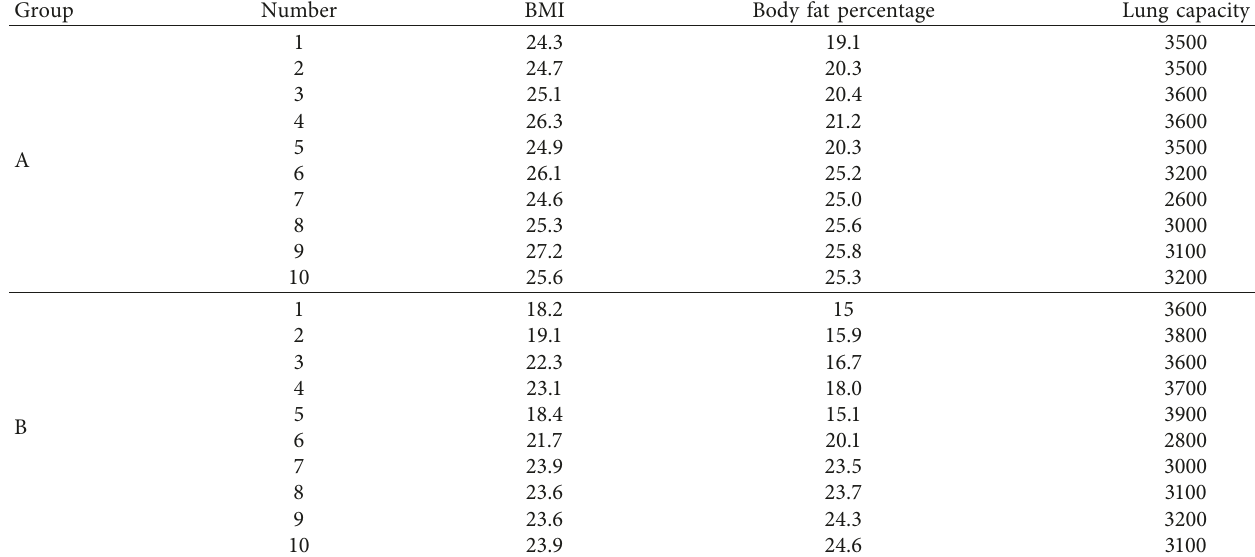
Table 4: Numerical table of test indicators for subjects before the experiment.